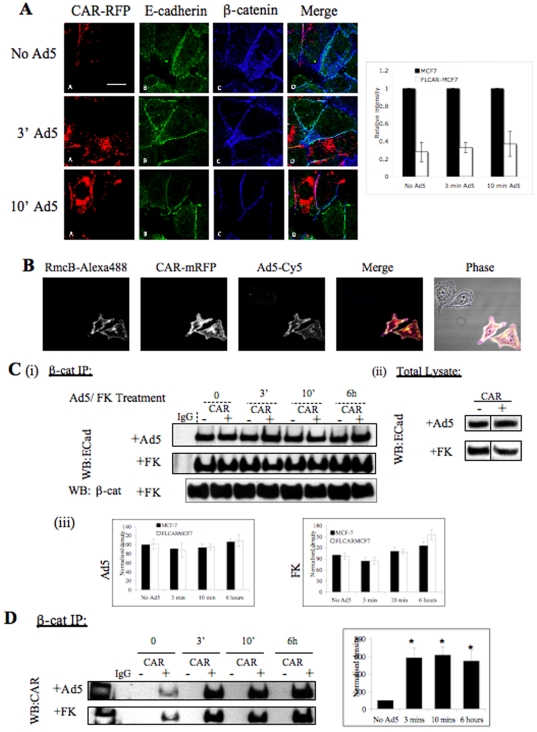
Ad5eGFP modulates CAR association with β-catenin.(A) (i) A mixed population of MCF7 and FLCARMCF7 cells were plated onto vitronectin-coated coverslips and incubated with Ad5eGFP at 9000 VP/cell for 3 minutes and 10 minutes before fixation. Cells were then immunostained for the .expression and localisation of E-cadherin (AB green) and β-catenin (AC; blue). Merged images are also shown (AD). Scale bars are 20 µm. Representative images are shown from 3 independent experiments with similar results. (ii) Bar charts are quantitations of E-cadherin intensity at junctions between FLCARRFP positive cells (FLCARMCF7), or those without CAR (MCF7) and calibrated on a per pixel basis to correct for any differences in junction size/area. MCF7 junction intensity values were normalised to 1 and all values for FLCARMCF7 junctions represented as a relative value to this. Values were pooled from multiple cells and images (n = >25 junctions per condition) over three independent experiments and represented as relative mean intensity. p>0.05 for E-cadherin in FLCARMCF7 vs MCF7 at all time points. (B) Fluorescence images demonstrating Ad5eGFP attachment to MCF7 and FLCARMCF7 cells. A mixed population of MCF7 and FLCARMCF7 cells were seeded onto vitronectin-coated coverslips. Cells were incubated with Ad5eGFP-Cy5 (9000 VP/cell) for 3 minutes at 37°C before fixation with 4% PFA and imaged by confocal microscopy. First two panels from left show FLCARMCF7 cells fixed and stained for CAR using RmcB (CAR-specific antibody) [1] followed by an Alexa fluor 488-conjugated secondary antibody (first panel) and RFP. Third panel shows Ad5eGFP-Cy5 attachment to cells and fourth panel from left shows merged image indicating FLCARMCF7 cells to which Ad5eGFP–Cy5 was bound. Ad5eGFP-Cy5 faint binding to MCF7 cells is also shown in the third and fourth panels. MCF7 cells in these panels are identified by lack of CAR or RFP expression. (C) (i) MCF7 and FLCARMCF7 cells were incubated with Ad5eGFP (+Ad5) at 9000 VP/cell or FK (+FK) at 160 µg/ml for 3 min, 10 min or 6 hours. Cells were then lysed and immuno-precipitated with β-catenin or control IgG followed by probing for E-cadherin. Blots were re-probed with β-catenin to control for loading and β-catenin re-probe of FK experiment is shown as an example. (ii) Whole cell lysates used for the β-catenin IP, run on a separate gel and shown for presentation. (iii) Bar charts showing mean densitometry quantification +/− SEM from four independent experiments showing relative levels of the E-cadherin/β-catenin complex for each Ad5 and FK treatments. (D) Blots as in experiments outlined in (B) re-probed for the presence of CAR. Bar chart is mean densitometry quantification +/− SEM from four independent experiments showing relative levels of CAR within the complex for Ad5 treatment. Significance was determined by a one-way anova. * = P<0.05.